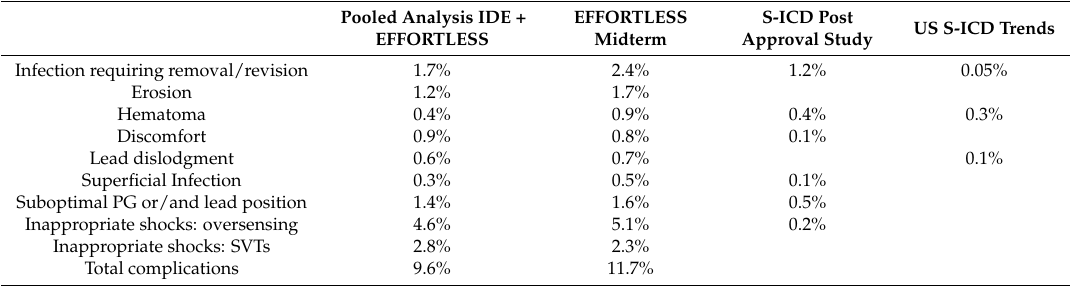
Table 3. S-ICD complications across prospective studies and real-life